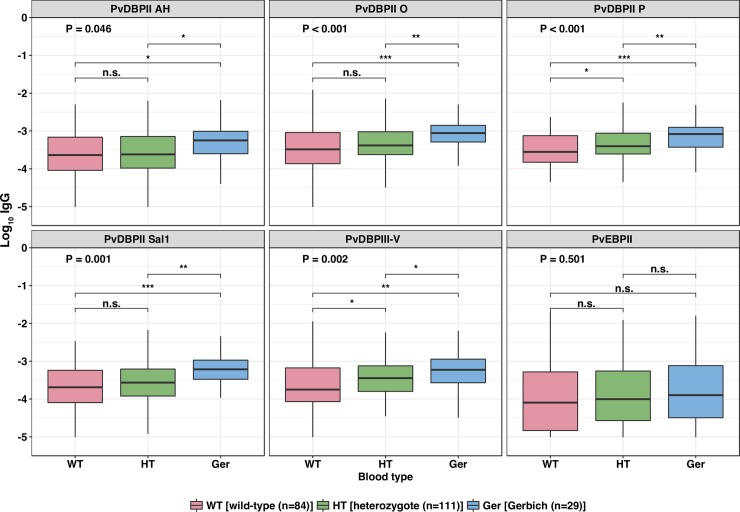
Gerbich blood type correlates with stronger antibody responses for PvDBPII variants.The overall differences among three groups by red blood cell phenotype were compared using Kruskal-Wallis one-way analysis, and individual comparison of each two groups was tested by Wilcoxon signed-rank sum method, star represents the comparison to wild-type group. P<0.05 were deemed significant. * denotes P<0.05, ** denotes P<0.01, *** denotes P<0.001.